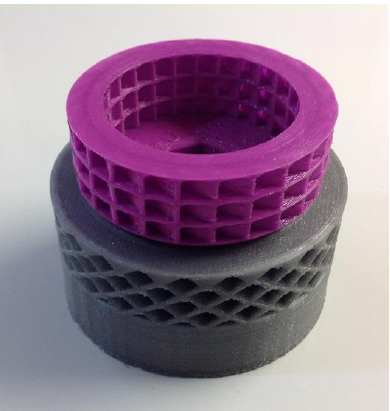
Figure 13. Micromodel of the mesh turbine rotor according to RF patent No. 203,833 (variant). Source: authors’ development.